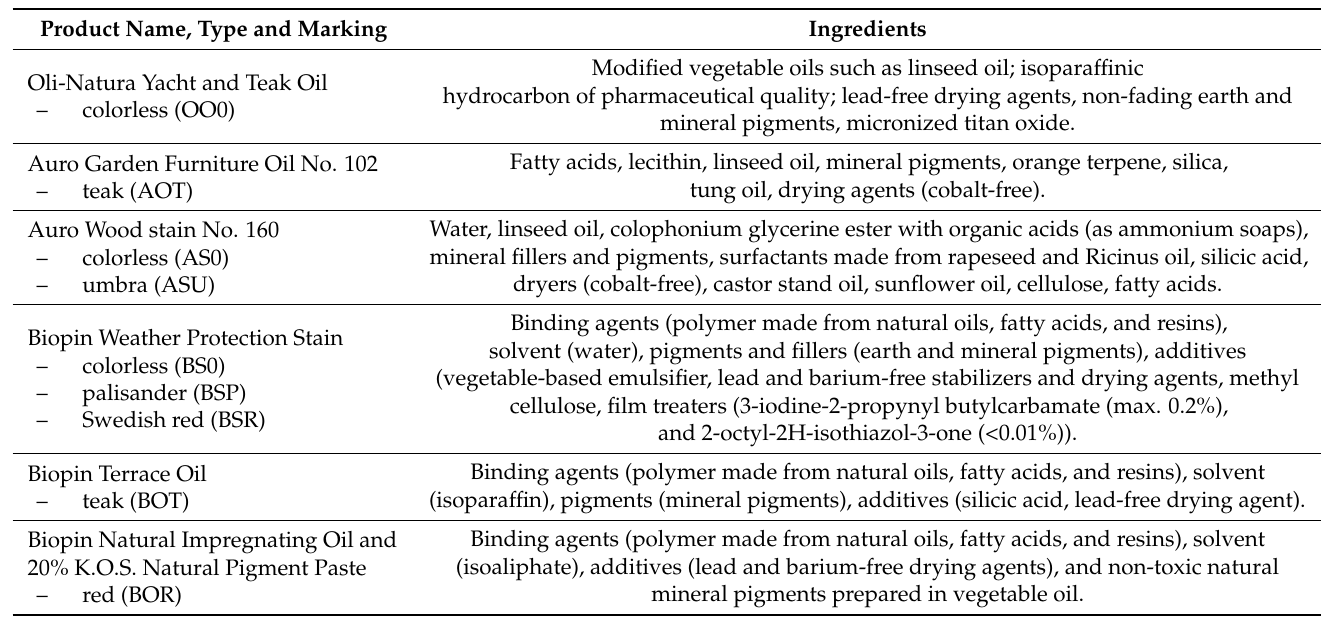
Table 1. Composition of tested